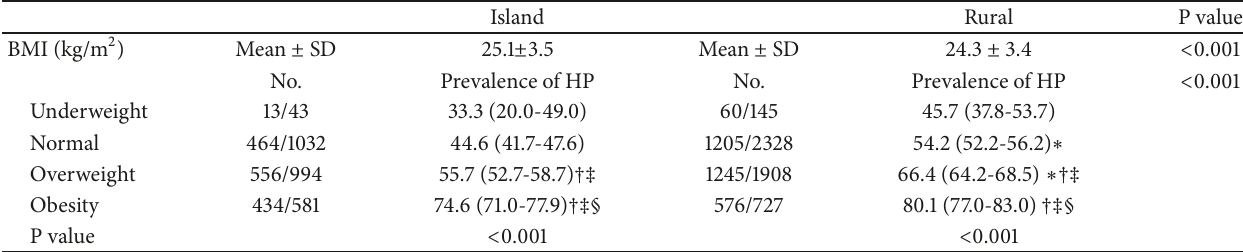
Table 5: Weighted prevalence of hypertension stratified by BMI in island and rural residents.